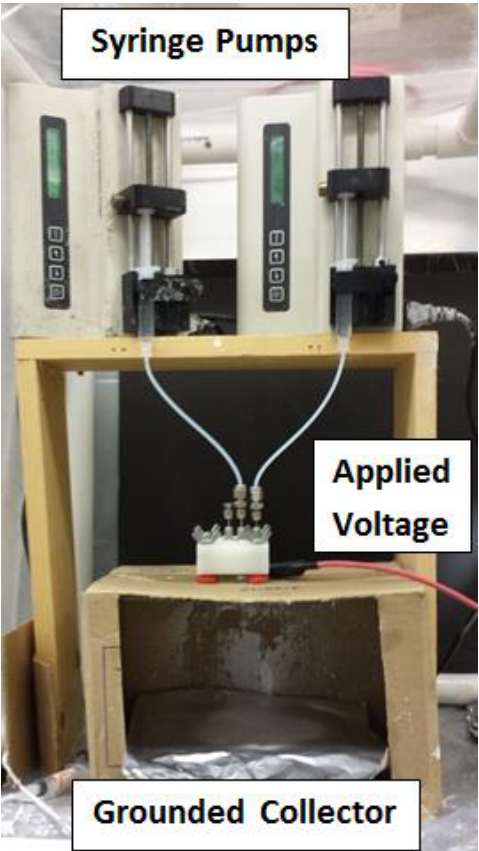
Figure 3. Core–Shell electrospinning